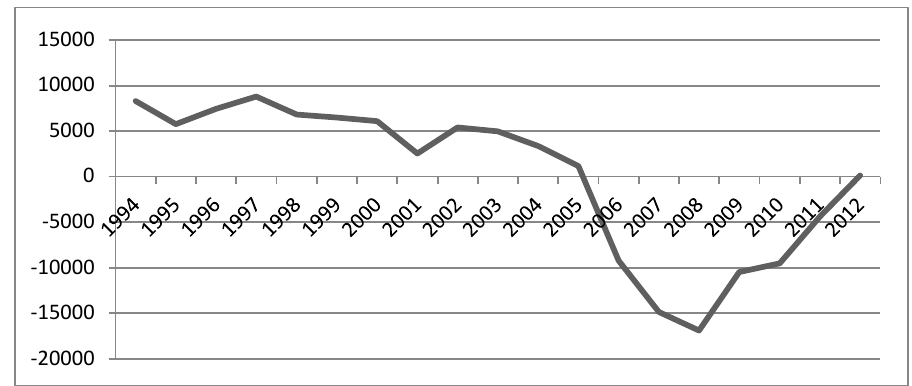
FIGURE 2: Savings by households in South Africa (in millions) Source: South African Reserve Bank,